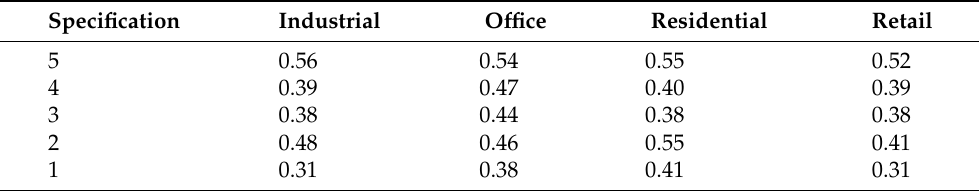
Table 5. Adj R 2 ’s for Models in Different Specifications.